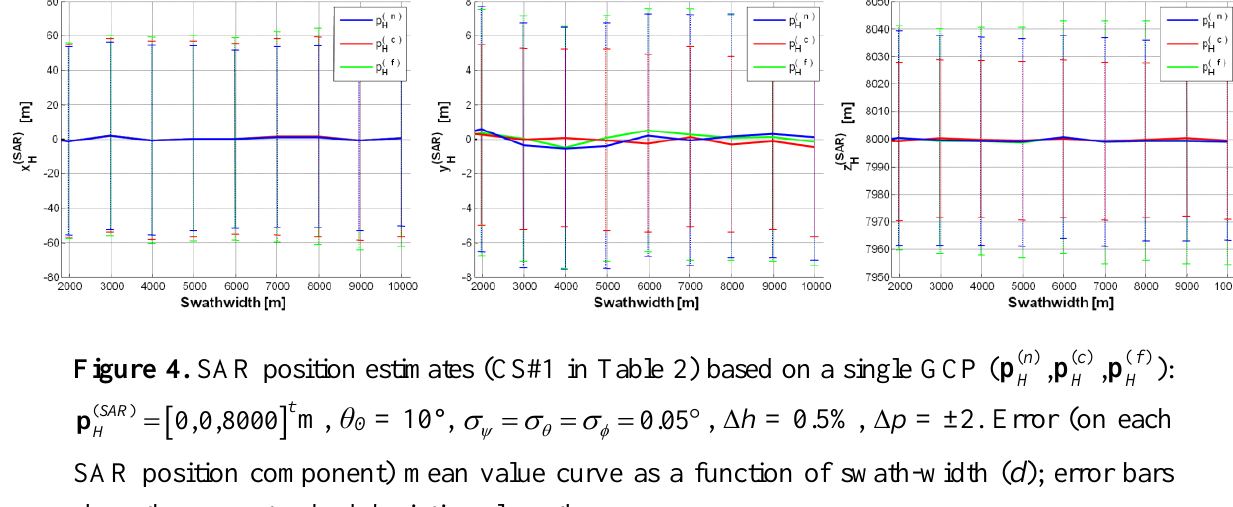
Figure 4. SAR position estimates (CS#1 in Table 2) based on a single GCP ( ( ) n SAR position component) mean value curve as a function of swath-width ( d ); error bars show the error standard deviation along the